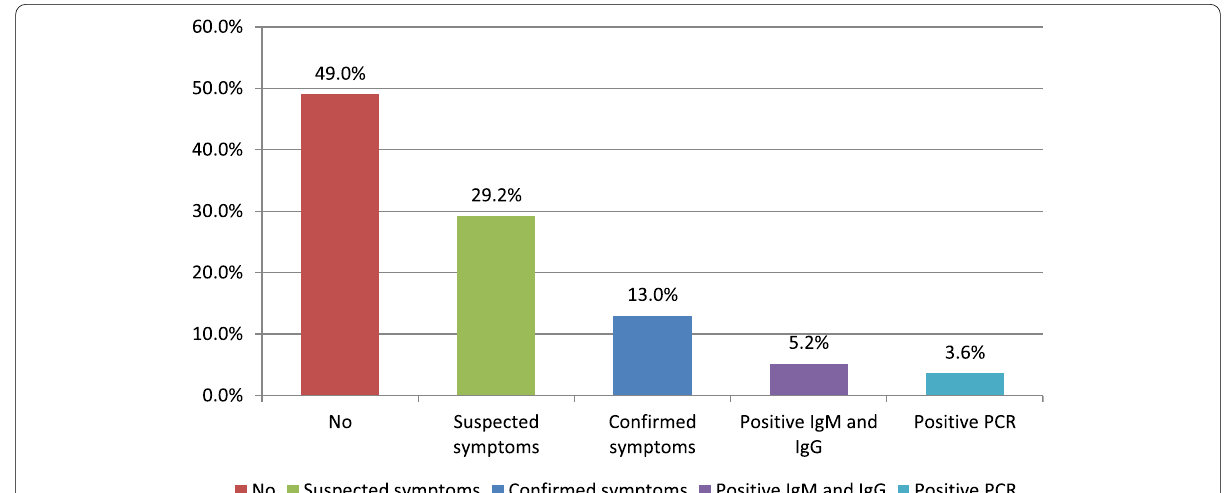
Fig. 1 COVID‑19 infection history among participating healthcare workers from Ismailia, Egypt in the 1st half of 2021 ( n